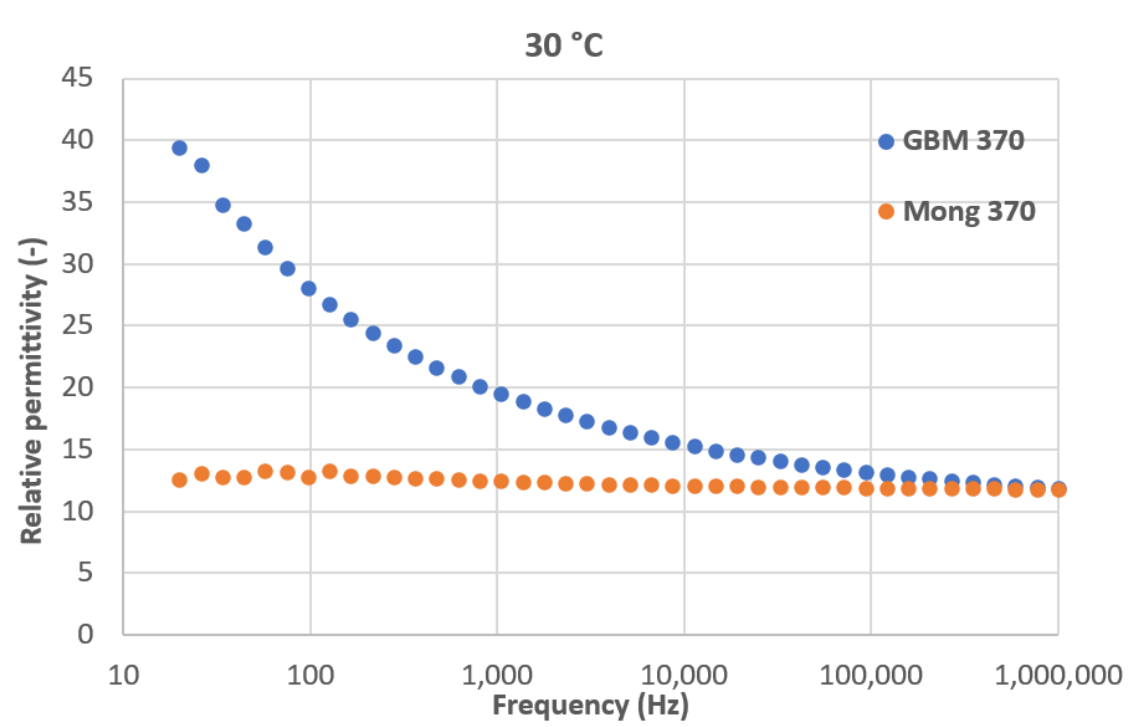
Figure 8. Relative permittivity dependence on frequency at room temperature for coatings sprayed with SD 370.